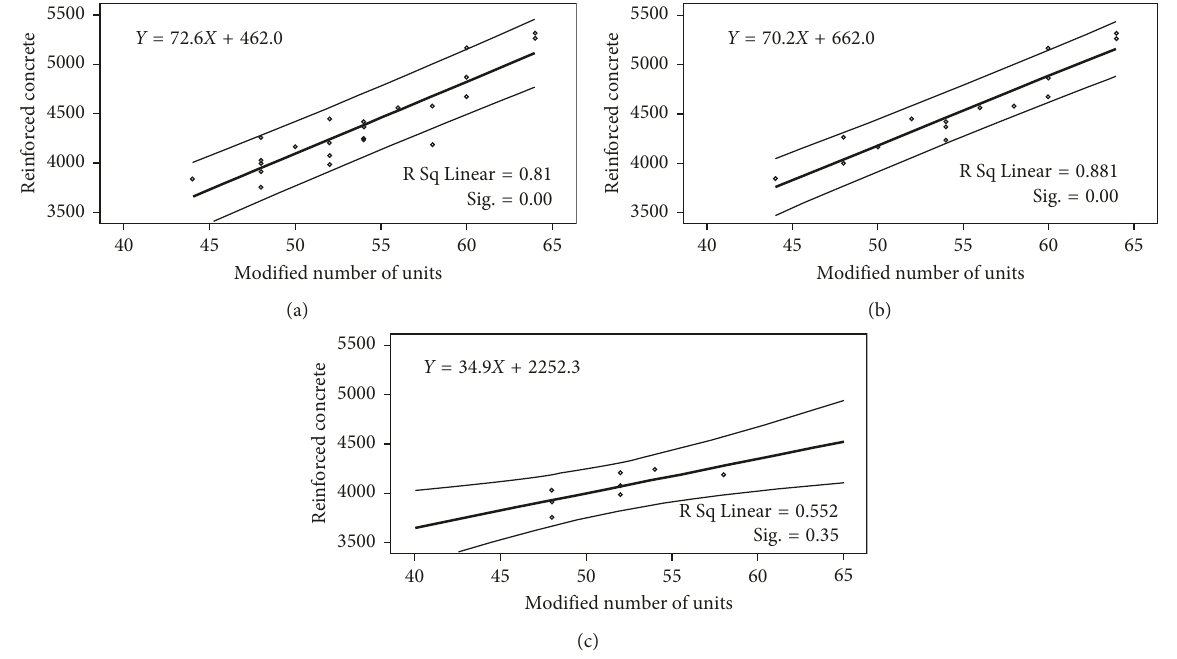
Figure 5: Statistical analysis (e.g., reinforced concrete). (a) Data group � 84m 2 , 4 units/floor. (b) Data group � 84m 2 , tower, 4 units/floor. (c) Data group � 84m 2 , flat, 4